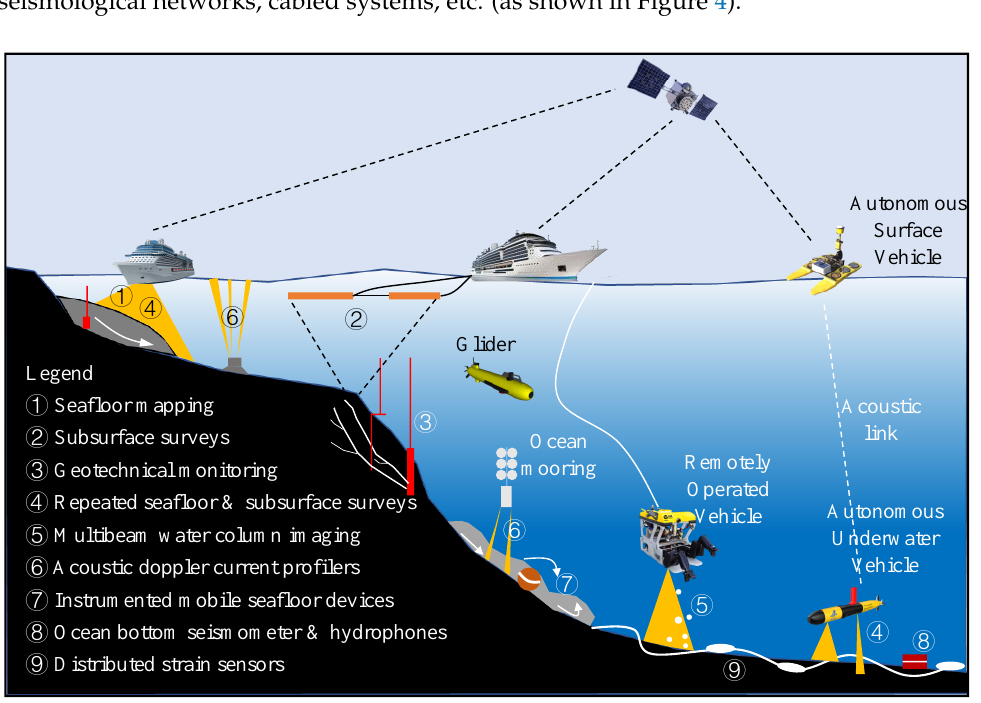
Figure 4. Conventional and emerging geophysical tools for submarine landslide in-situ investigations. Modified from [23].